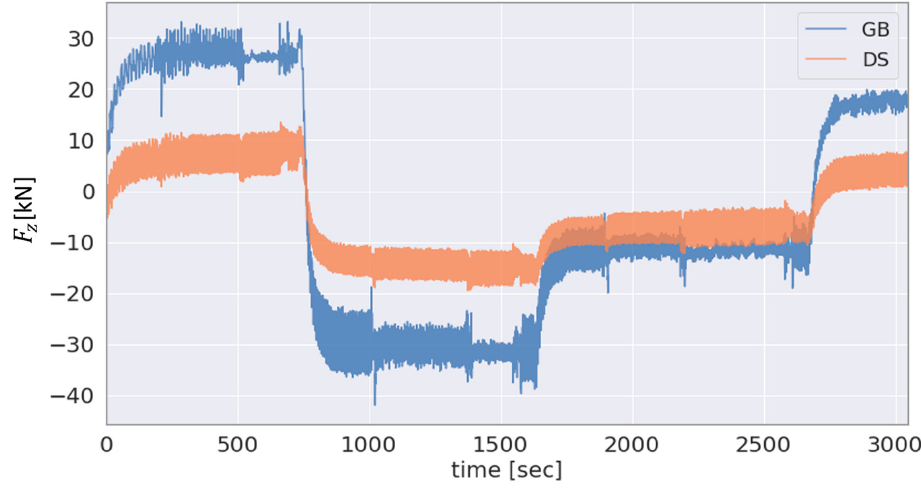
Figure 13. SG-based GB input force F z .